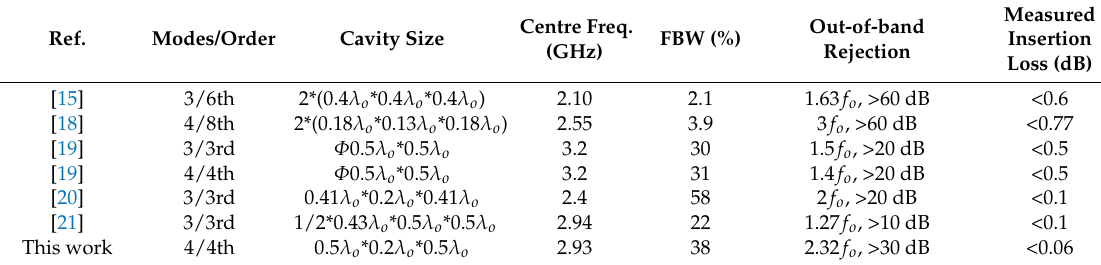
Table 1. Comparison among similar cavity